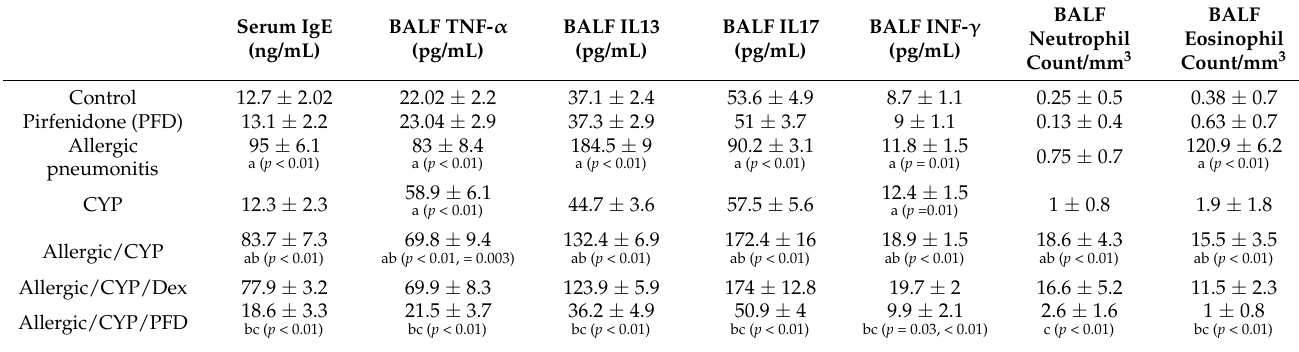
Table 2. The effect of pirfenidone on the serum IgE and BALF levels of inflammatory cy- tokines, eosinophil, and neutrophil count in allergic pneumonitis/CYP-exposed rats at the end of the